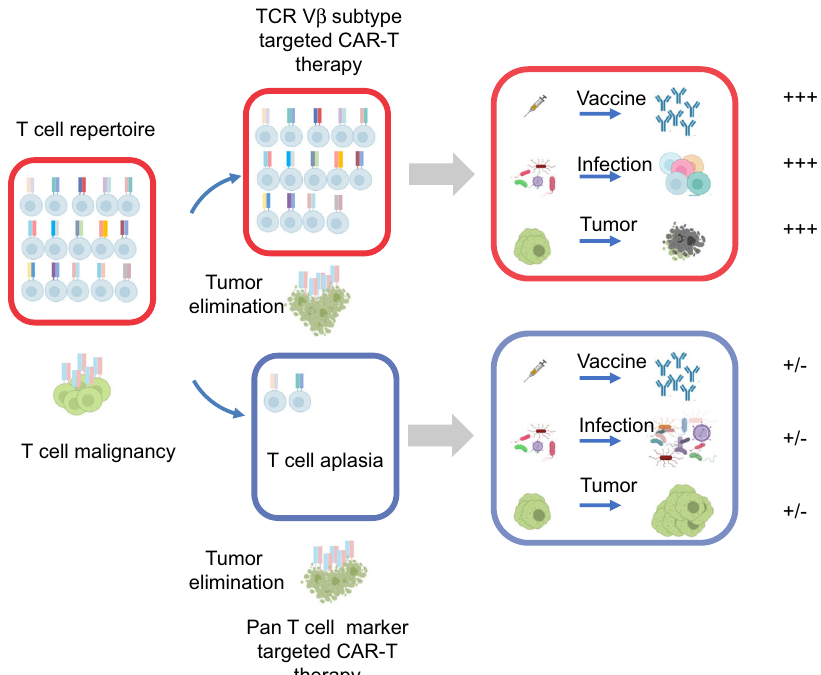
Fig. 7 | Proposed model of how TCR V β -targeting CAR-T cell treatment elim- inatesTcellmalignanciesandmaintainssuf fi cientTcell-mediatedimmunity. T cell malignancies are mostly monoclonal or oligoclonal. When pan T cell markers are used for CAR-T cell targets, CAR-T cells eliminate both malignant T cells and normal T cells. This strategy will cause T cell aplasia in the host and weak immune